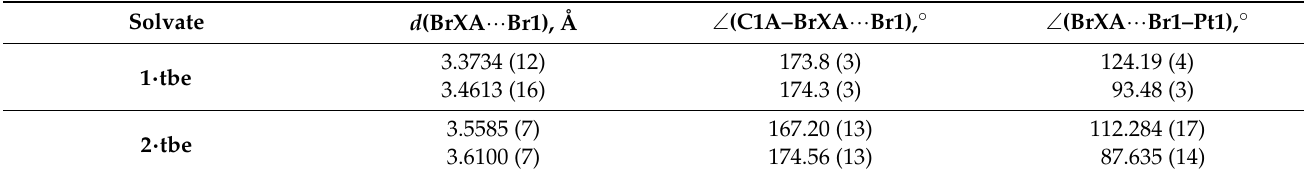
Table 1. Parameters of XB in adducts 1 · tbe and 2 · tbe (X = 1, 2). Solvate